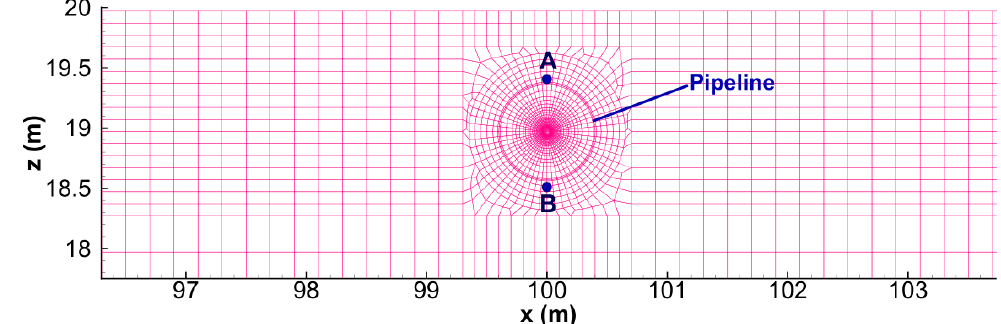
Figure 2. Mesh system of the pipeline-seabed in computation (Noted: The crude oil in pipeline is also considered, and only the mesh around the pipeline is shown).